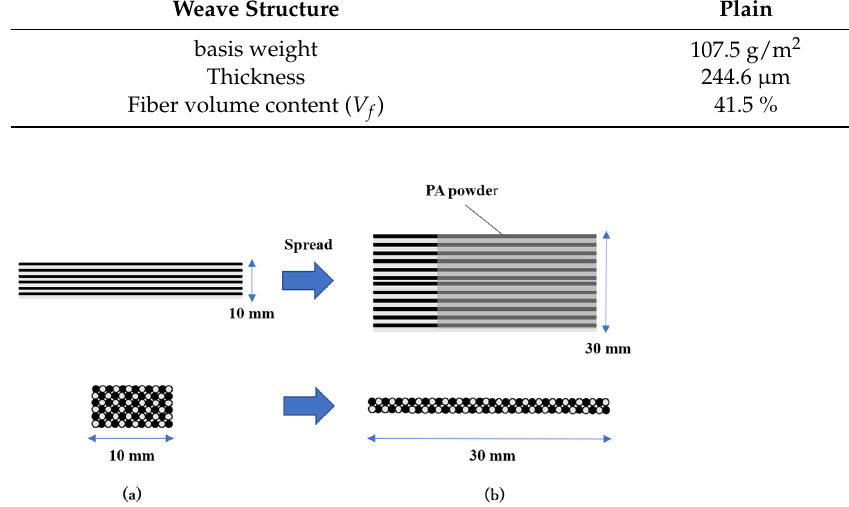
Table 2. Specifications of woven fabric using commingled yarn (Manufacture; Harmoni Industry Co. Ltd., Fukui, Japan). Table 3. Specifications of laminated materials. Table 3. Specifications of laminated materials.